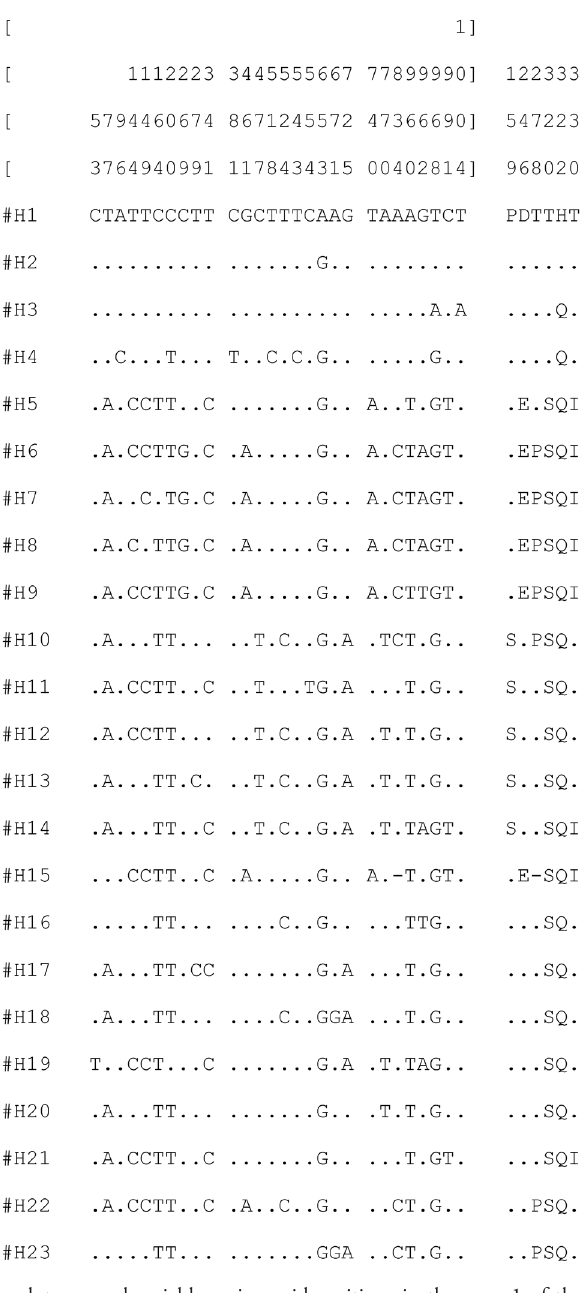
Figure 3. DNA haplotypes and variable amino acid positions in the exon 1 of the gene tim from C. pipiens f. “pipiens” and C. pipiens f. “molestus”. Haplotypes numbers and variable nucleotide sites are shown on the left. Variable amino acid sites are shown on the right. Only variable haplotypes are shown, all 79 sequences are presented in Suppl. material 3. Positions of the variable sites shown on the top. Dash show deletion of 12 nucleotides (sites 831-842) in exon 1 in C.pipiens f. “pipiens” from Moscow